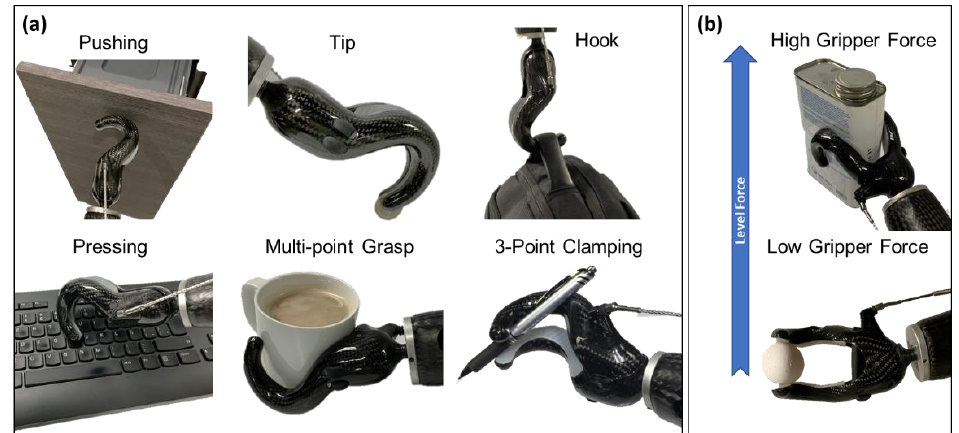
Figure 9. Functional design: ( a ) functions and ( b ) level force.